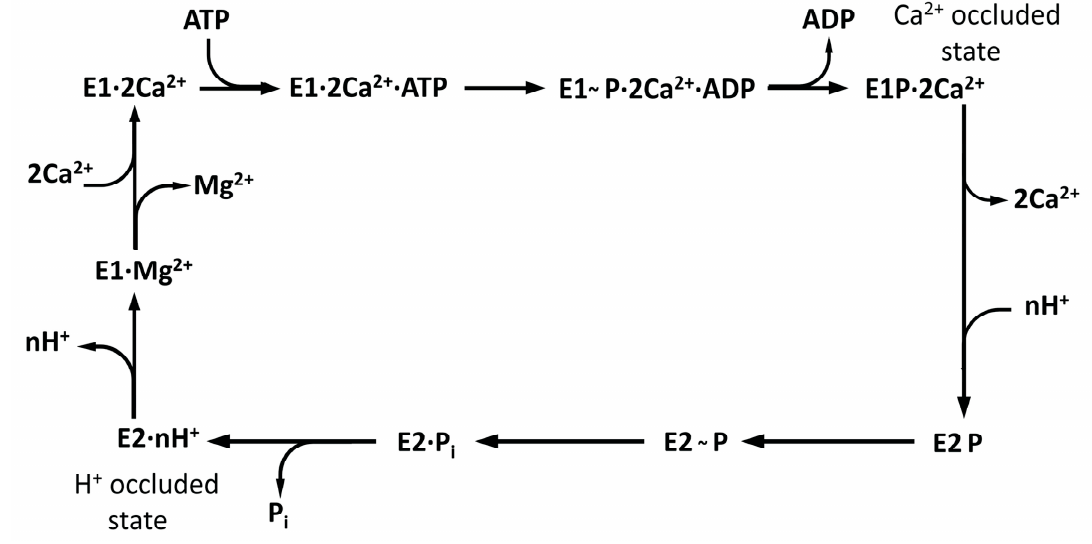
Figure 9. Scheme of catalytic and transport steps of the SERCA1a cycle of calcium pumping (loosely adapted from Figure 1 in reference [13]).